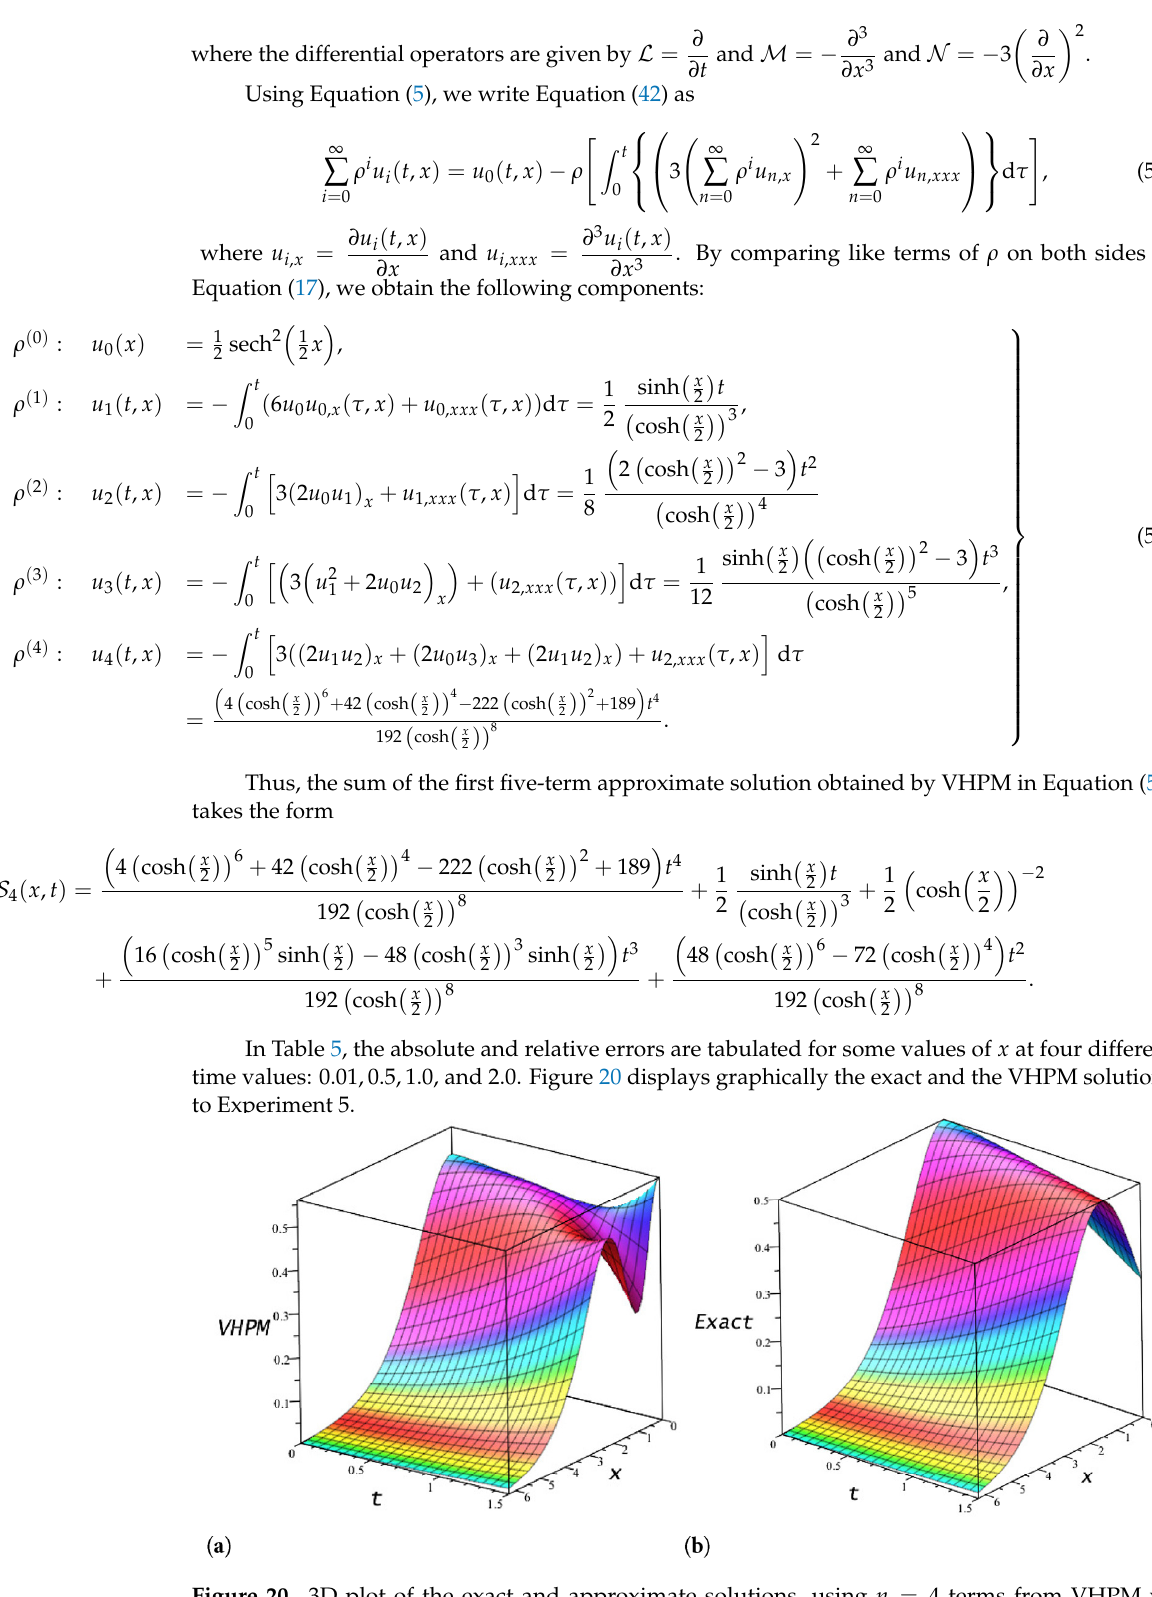
Figure 20. 3D plot of the exact and approximate solutions, using n = 4 terms from VHPM